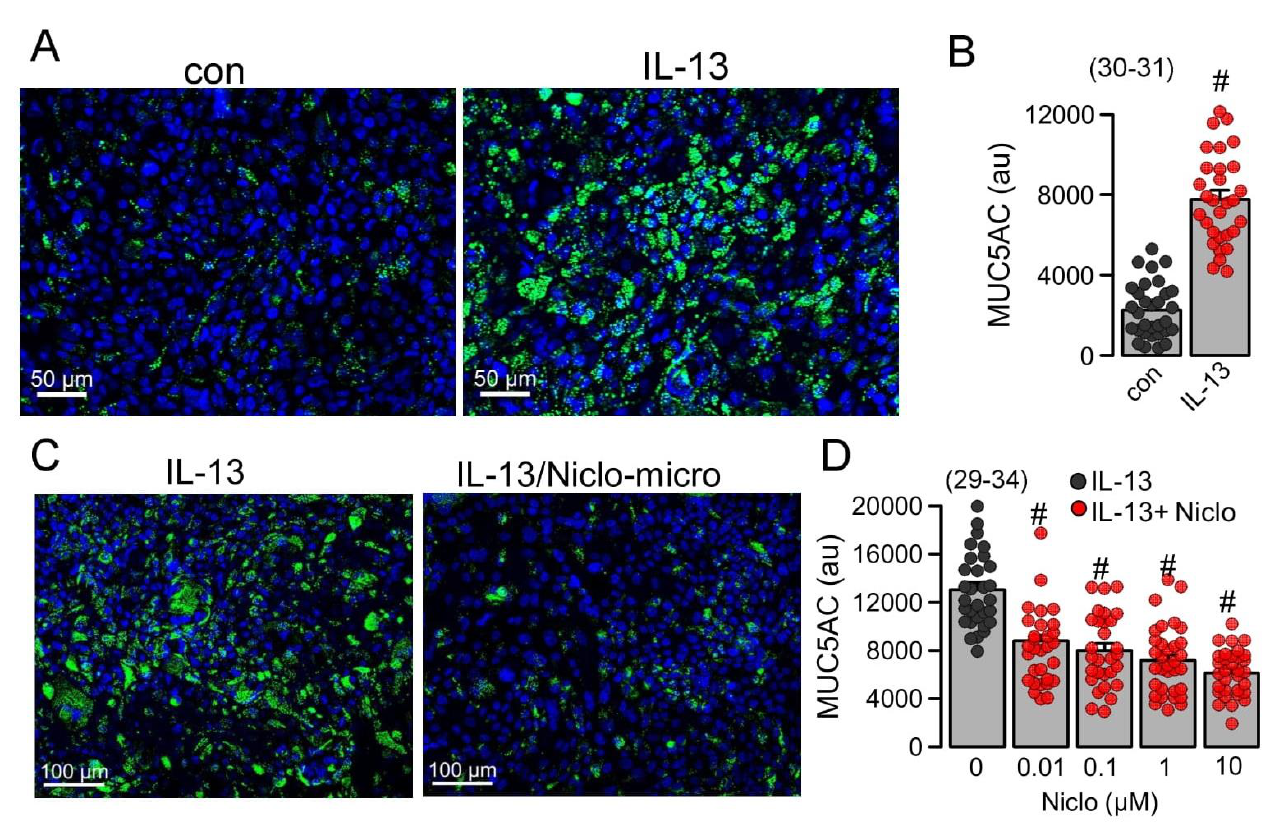
Figure 6. Inhibition of MUC5AC in Calu-3 human airway submucosal cells by Niclo-spheres. ( A ) Induction of MUC5AC expression (green fluorescence) in Calu-3 cells. Bar = 50 µ m. ( B ) Quantitative analysis of MUC5AC expression indicates significant upregulation by IL-13 (20 ng/mL/72 h). ( C ) Inhibition of MUC5AC expression by niclosamide-loaded microspheres (Niclo-micro). Bar = 100 µ m. ( D ) Concentration-dependent inhibition of MUC5AC expression by niclosamide-loaded microspheres. Mean ± SEM (number of sections analyzed). # significant difference when compared to control ( p < 0.05; unpaired t -test) or IL-13 ( p < 0.05; ANOVA).